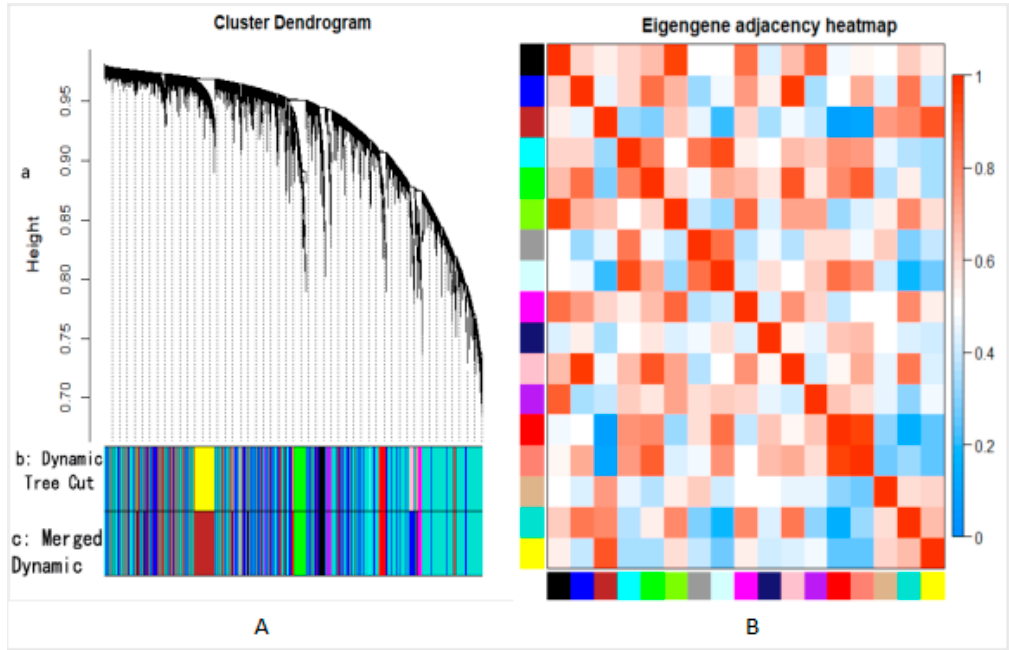
Figure 2. ( A ) System clustering tree of all samples after classification. Part a is the clustering tree constructed by genes, part b is the gene module obtained by clustering, and part c is the gene module obtained by combining similar expression patterns; ( B ) The thermal map of the relationship between the eigenvalues of different modules.